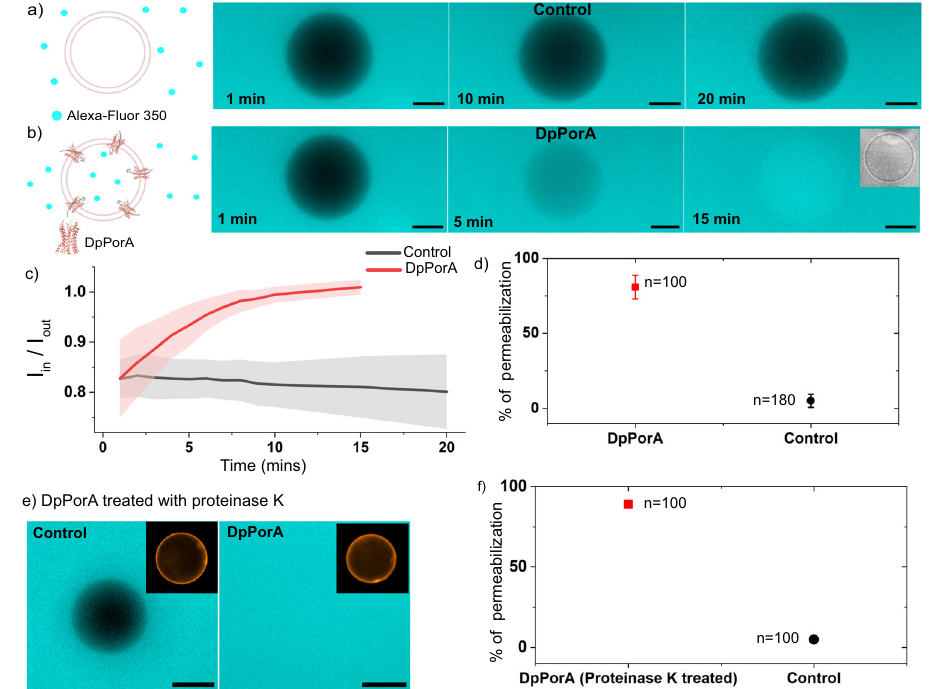
Fig. 4 | Functionalassembly of DpPorA in giant unilamellarvesicles. Schematic and representative fl uorescence image of single vesicle outlining the transport of molecules in a time-dependent manner in the a absence of a pore and b in the presence of DpPorA, where false blue color represents the Alexa-Fluor 350 dye in vesicles. Inset shows the phase-contrast image of the vesicle. c Time-dependant curve of normalized intensity of single vesicles with DpPorA ( n =24 individual vesicles) and without peptide ( n =10 individual vesicles) is represented over time; red and black lines represent the mean values. The shaded region (error bands) represents the corresponding standard error of the mean. d Vesicle permeabili- zation percentage is shown in the absence and presence of DpPorA. Permeabili- zation percentage of DpPorA is 80.9±7.9% (red, mean±SD from n =100 vesicles